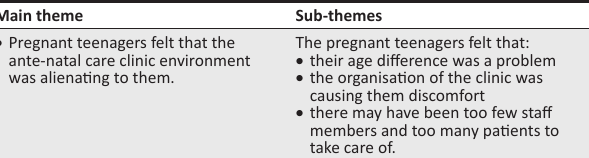
TABLE 1: Perceptions of pregnant teenagers of the antenatal care clinic